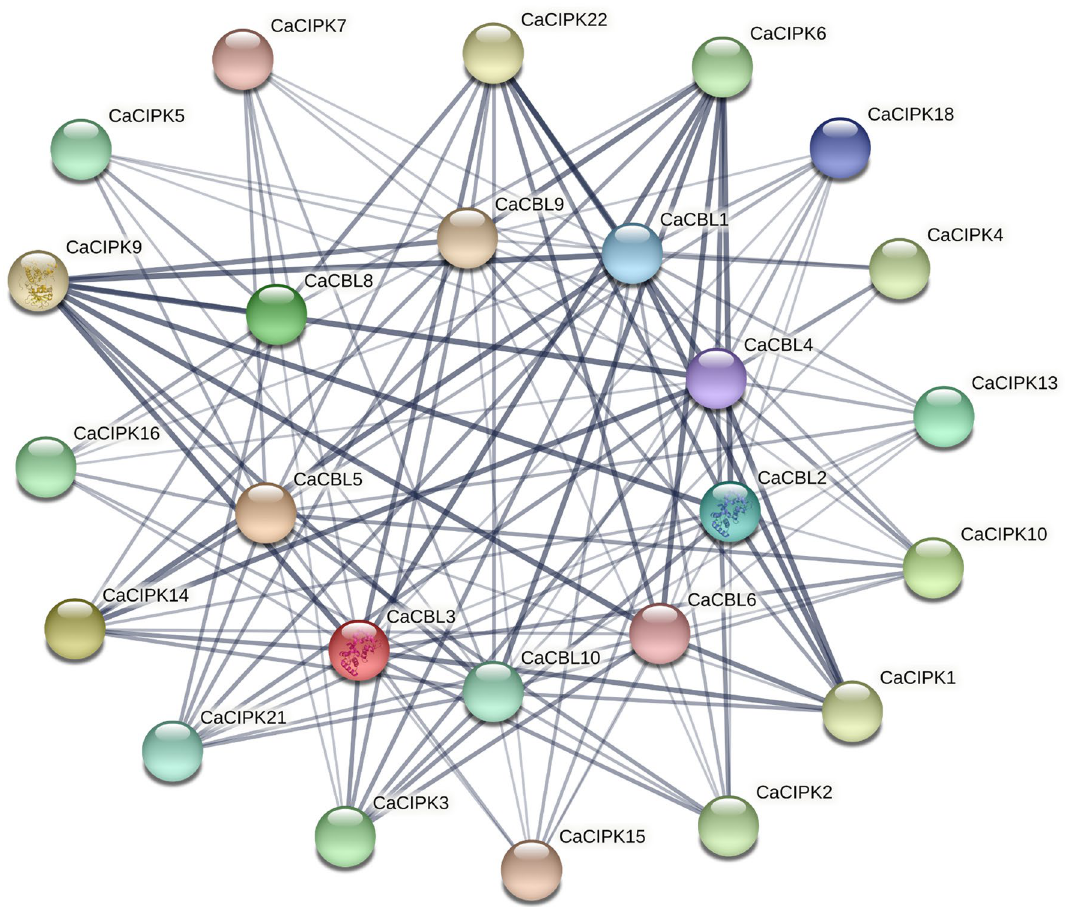
Figure 7. Interaction networks of CaCIPKs and CaCBLs based on chickpea homologs in the STRING database. The best matching sequence of CaCIPK protein with chickpea on the basis of identity, bitscore and e-value has been shown in the figure. Experimental data of CBL and CIPK interaction in chickpea was constructed by using the confidence value > 0.4. The thicker and thinner lines represent strong and weak interaction